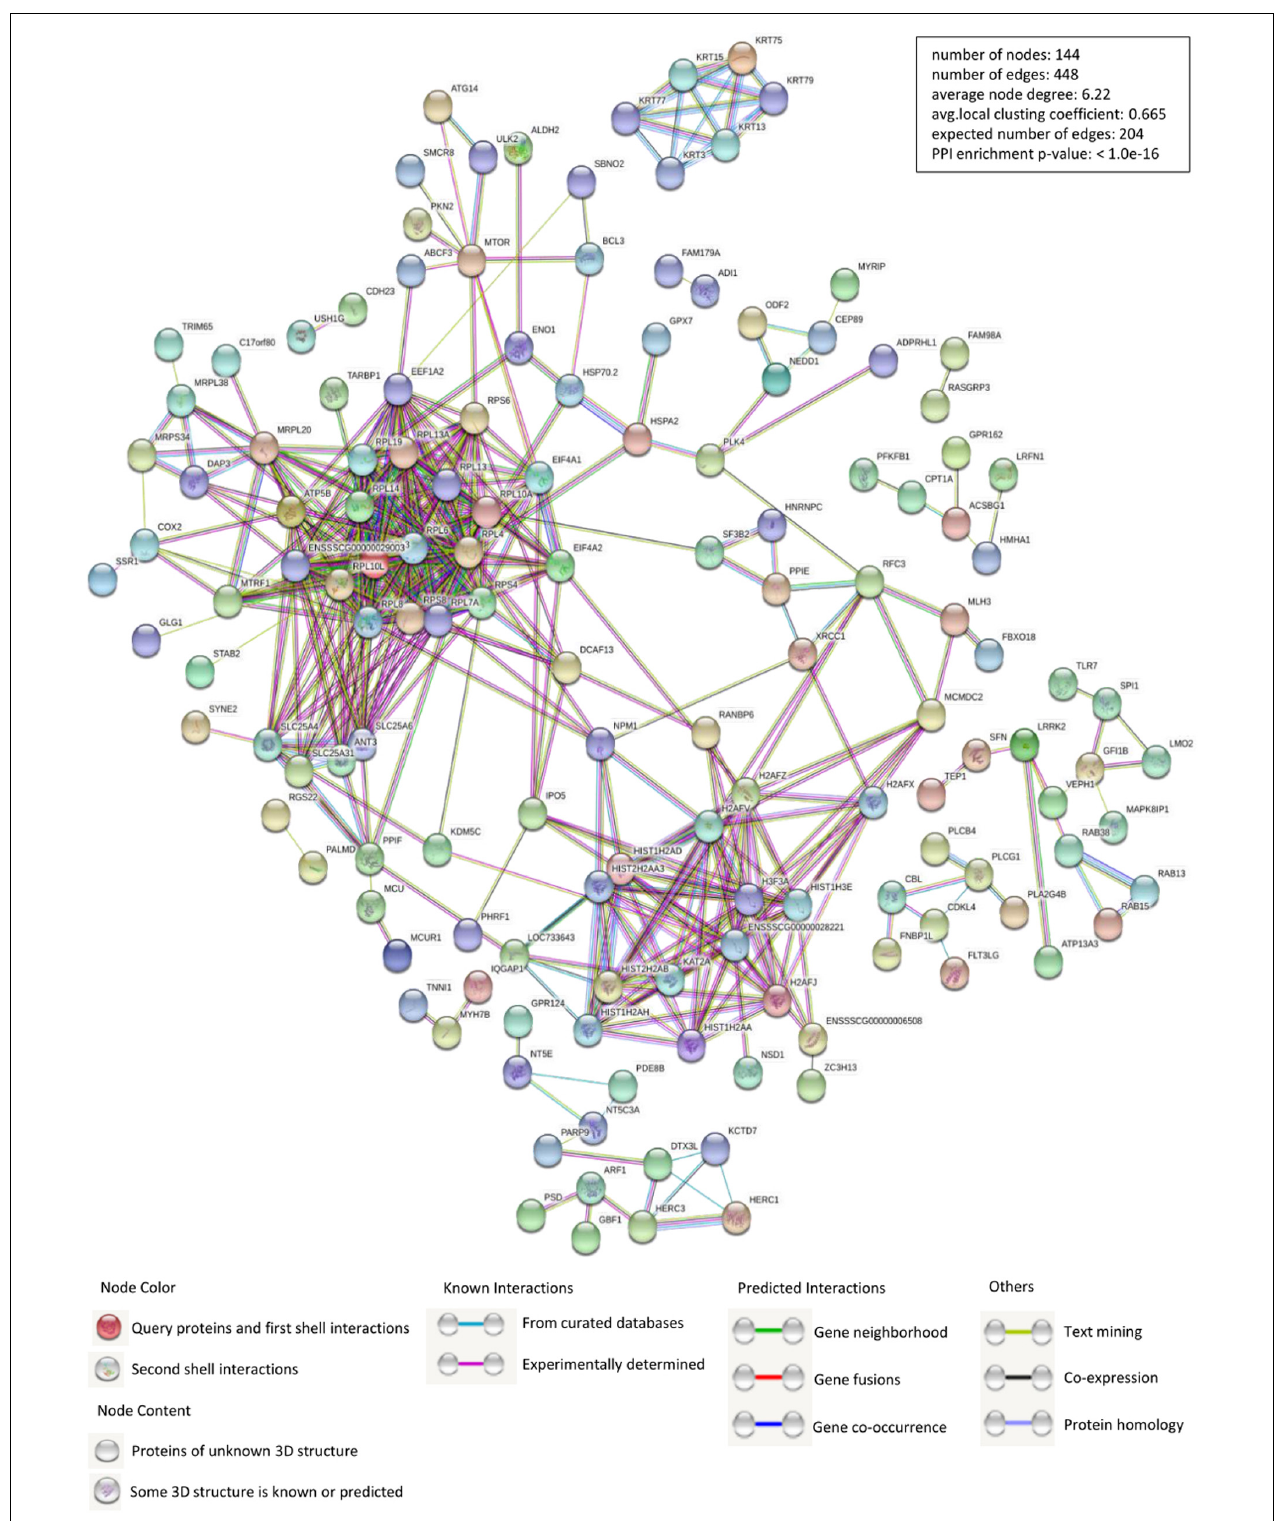
FIGURE 2 | Construction and analysis of the protein-protein interactions (PPIs) network using STRING database. Each edge color indicates a different method of PPIs prediction as indicated below the figure. The map of PCV2 Cap-interacting host proteins further interacting with the other proteins of our data were constructed and plotted by using the network analyzer tool of “Cytoscape version 3.7.1.” The corresponding symbols indicating different protein classes have been mentioned on the figure. Proteins have been represented as the respective NCBI gene names ( Supplementary Table S2 ).